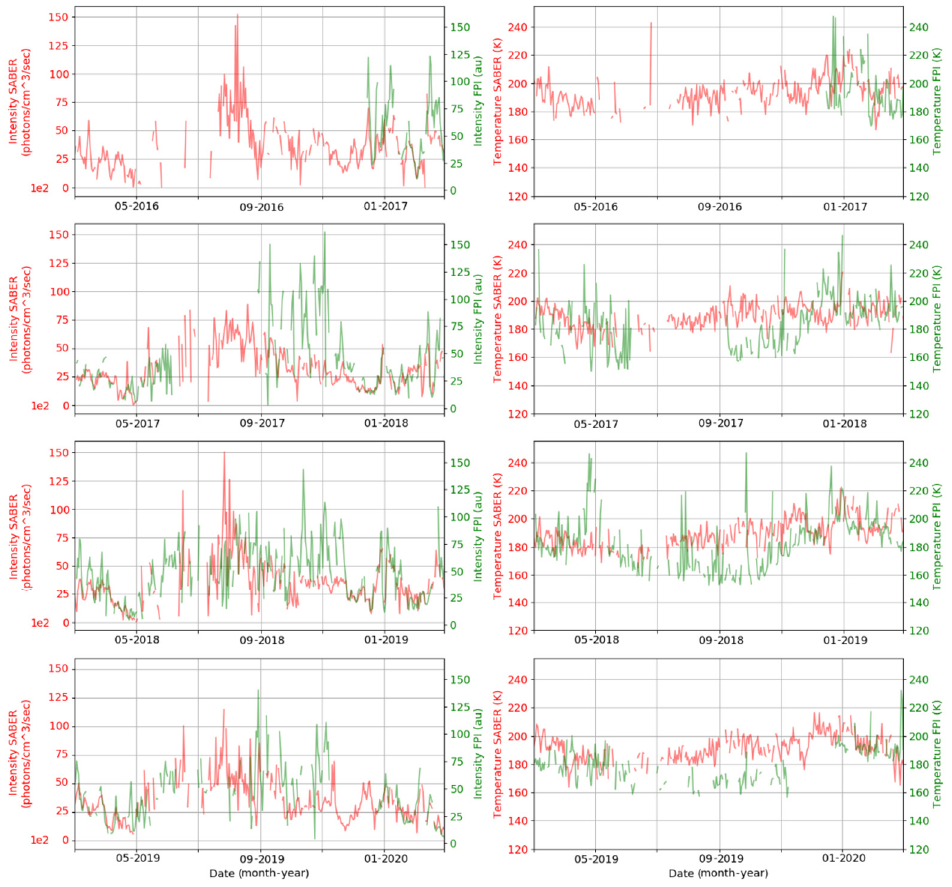
Figure 12. Results of intensities and temperatures comparison after the intensity peak is shifted to 97 km. Left : intensities, right : temperatures. SABER (red) and FPI (green). Presented data calculated using [20] .